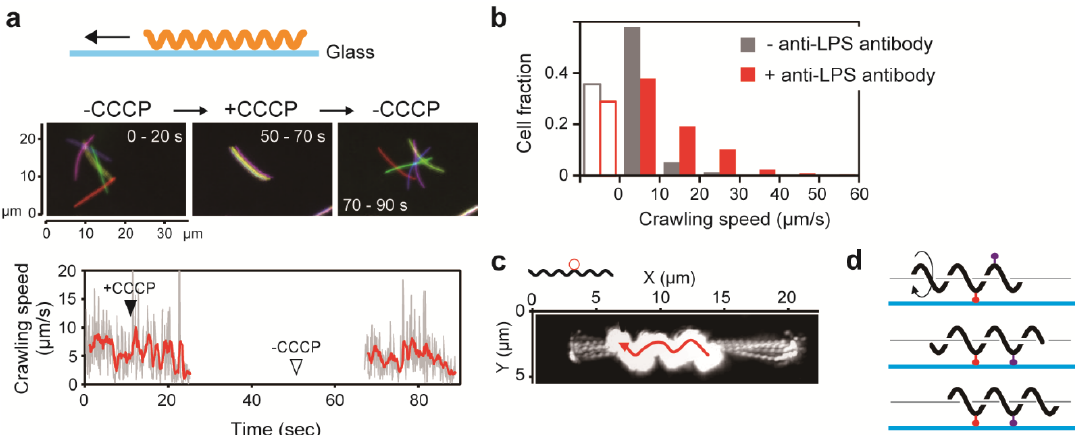
Figure 5. Crawling motility of Leptospira . ( a ) E ff ect of carbonyl cyanide m-chlorophenylhydrazone (CCCP) on Leptospira crawling on a glass surface. ( b ) E ff ect of anti- lipopolysaccharide (LPS) antibody on crawling speed. Open bars indicate the fractions of cells adhered to the glass without crawling. ( c ) Movement of a microbead coated with anti-LPS antibody on the leptospiral cell surface. Sequential frames of a movie were superimposed to show the bead trajectory. ( d ) Schematic explanation of crawling. Adhesive molecules (red and purple symbols), such as LPS, anchor the cell to a surface, and PF-dependent rolling of the protoplasmic cylinder propels the cell.